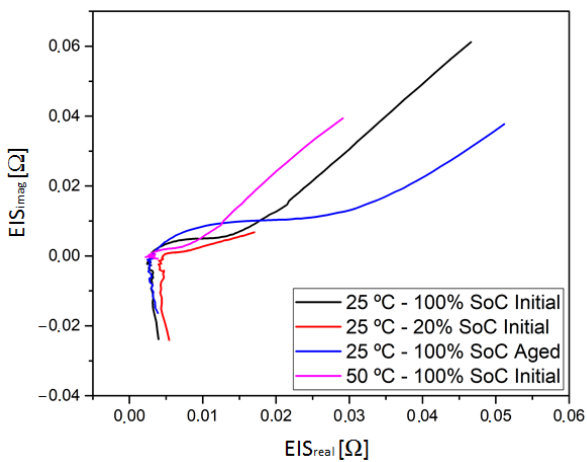
Figure 1. Sample Nyquist plots for a new and aged battery at different temperatures and SOC.